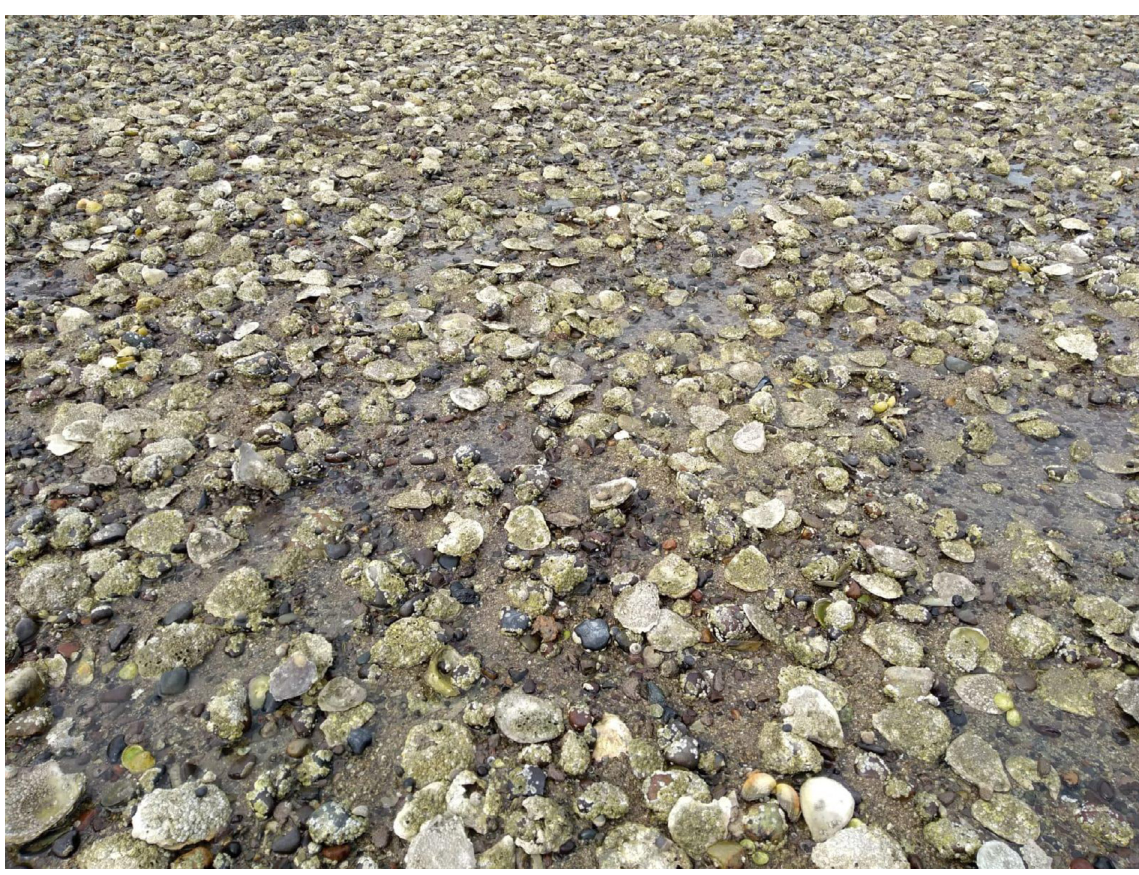
Fig. 6. Large quantities of European fl at oyster shell debris photographed in 2019 on the shores at Beaumaris in the Menai Strait, an area known as a historical oyster bed (site 2 in Fig.